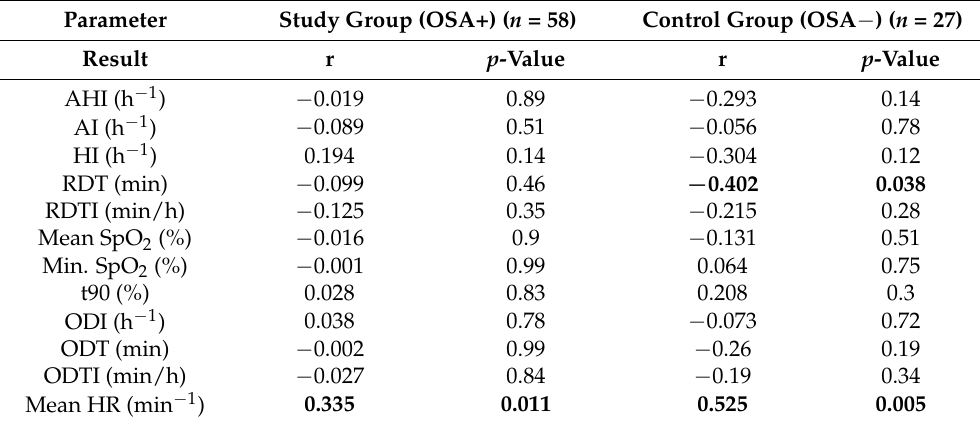
Table 3. Fetuin-A level and polygraphy results relationships in the study (OSA+) and control (OSA − ) groups (significant results bolded). Parameter Study Group (OSA+) ( n = 58) Control Group (OSA − ) ( n = 27) Result r p -Value r p -Value AHI (h − 1 ) − 0.019 0.89 − 0.293 0.14 AI (h − 1 ) − 0.089 0.51 − 0.056 0.78 HI (h − 1 ) 0.194 0.14 − 0.304 0.12 RDT (min) − 0.099 0.46 − 0.402 0.038 RDTI (min/h) − 0.125 0.35 − 0.215 0.28 Mean SpO 2 (%) − 0.016 0.9 − 0.131 0.51 Min. SpO 2 (%) − 0.001 0.99 0.064 0.75 t90 (%) 0.028 0.83 0.208 0.3 ODI (h − 1 ) 0.038 0.78 − 0.073 0.72 ODT (min) − 0.002 0.99 − 0.26 0.19 ODTI (min/h) − 0.027 0.84 − 0.19 0.34 Mean HR (min − 1 ) 0.335 0.011 0.525 0.005 AHI, apnea/hypopnea index; AI, apnea index; HI, hypopnea index; RDT, respiratory distress time; RDTI, respiratory distress time index; SpO 2 , oxygen saturation, t90, SPO 2 < 90% time; ODI, oxygen desaturation index; ODT, oxygen desaturation time; ODTI, oxygen desaturation time index; HR, heart rate. In both the OSA+ and OSA − groups, there was no dependence of Fet-A levels on systolic, diastolic, or mean arterial pressure. In the OSA − but not OSA+ group, a statisti- cally significant ( p = 0.02) positive correlation between Fet-A concentration and pulse pressure (r = 0.466) was demonstrated. The subjects OSA+ and OSA − were divided into three groups depending on the level of Fet-A: low (259.8–364.2 µ g/mL), medium (364.6–405.8 µ g/mL), and high (407.2–565.7 µ g/mL). High Fet-A levels were most often found in the OSA+ group, whereas in the OSA − group, the most common Fet-A level was